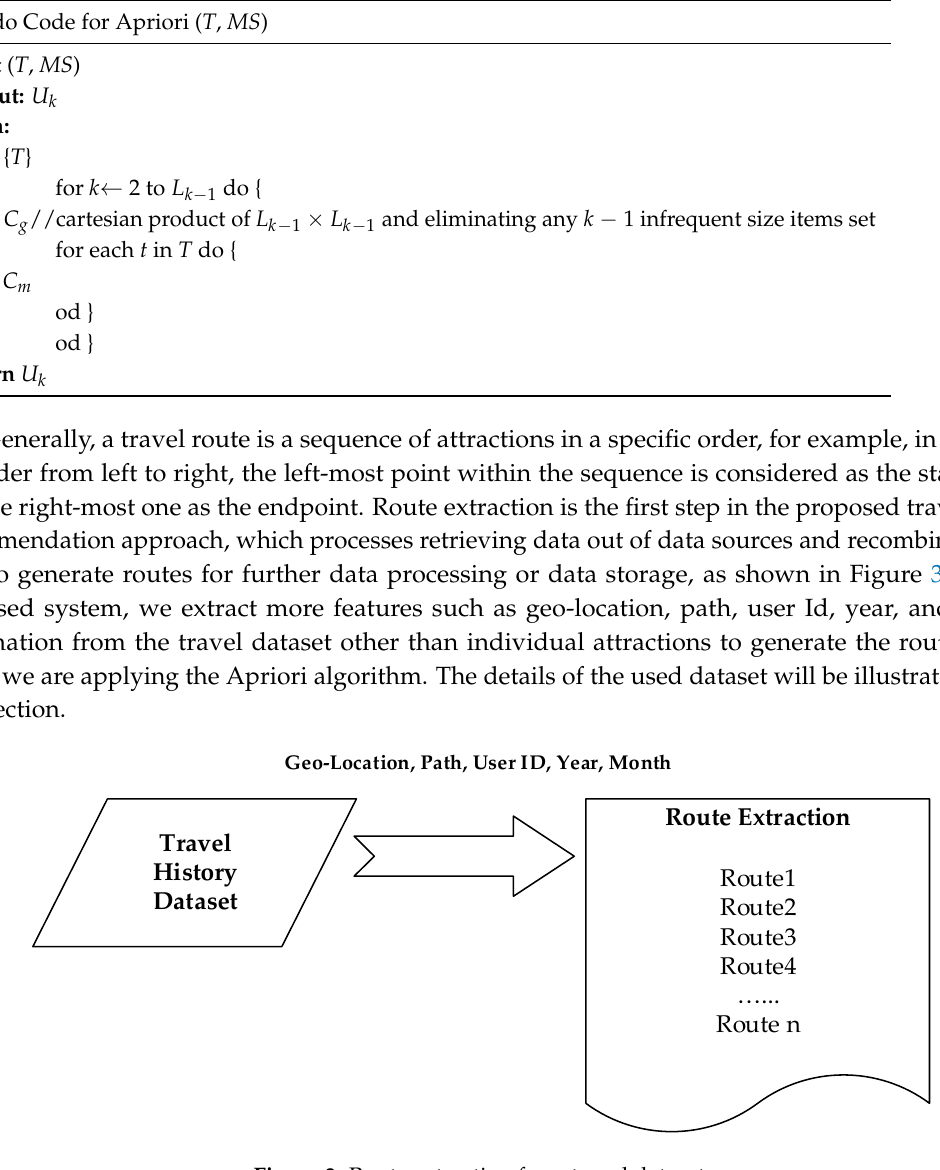
Figure 3. Route extraction from travel dataset.